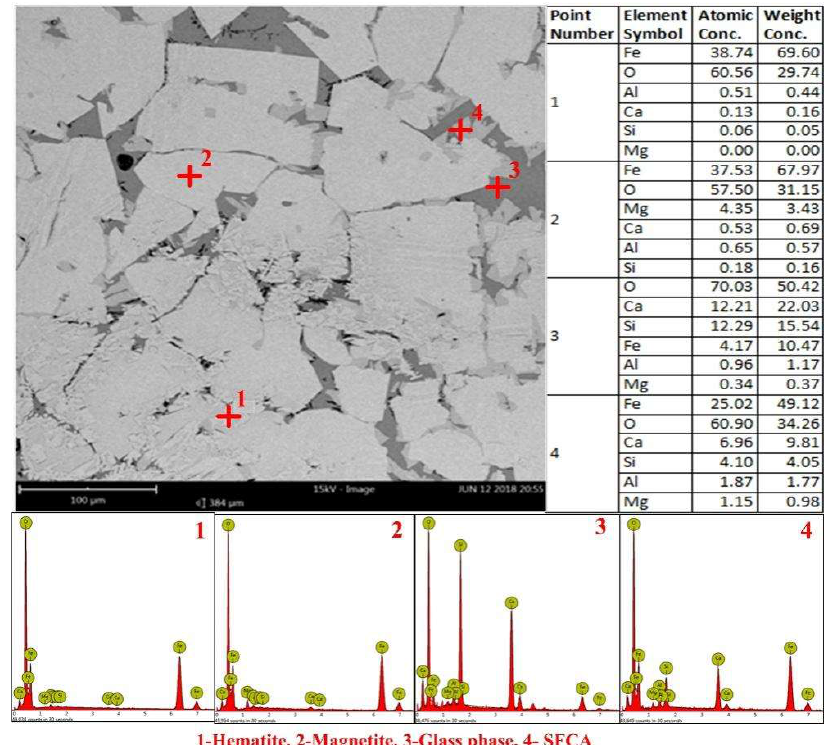
Figure 9. Distribution of main elements in different minerals of sinter.